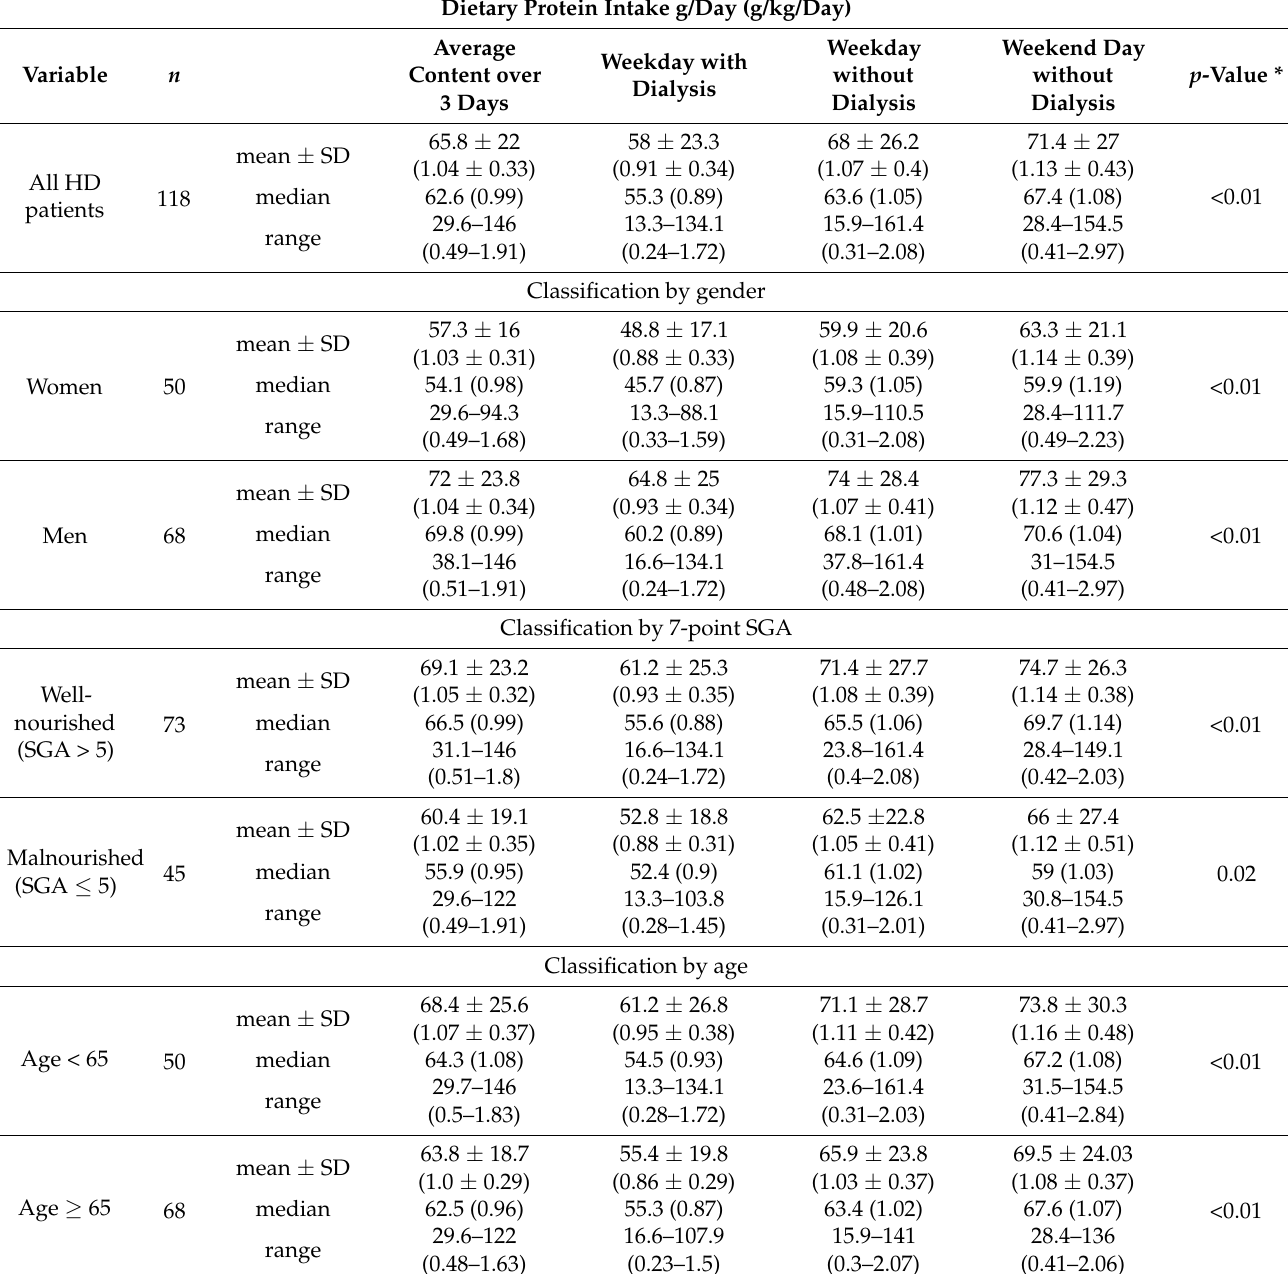
Table 4. Comparison of dietary protein intake on a weekday with dialysis, a weekday without dialysis, and a weekend day without